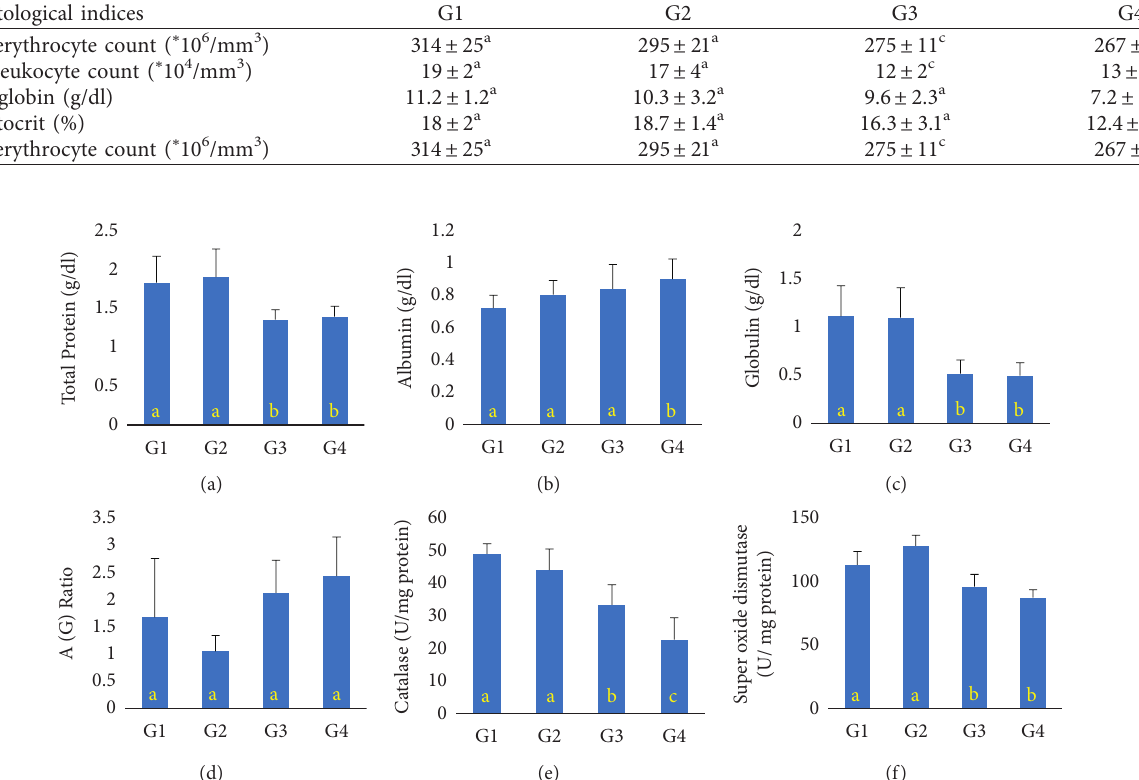
Figure 3: (a) Total protein level was comparable between control and G1. It was significantly low in G3 and G4. (b) Albumin was high at all three concentrations in AsNPs treated groups. The difference was significant between G1 and G4. (c) Globulin was significantly low in G3 and G4 groups as compared to G1 group. (d) A/G ration was high in G3 and G4. (e) Catalase was low in all AsNPs treated groups with the lowest in G4. (f) Superoxide dismutase level was significantly low in G3 and G4 groups. Columns showing different letters are significantly different ( ∗ p < 0 . 05) (G1: control, G2: 1 mg/l, G3: 10mg/l, and G4: